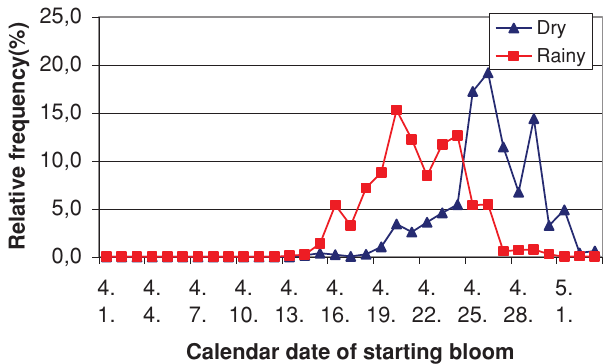
Figure 4. Time series of the beginning of bloom in pear gene bank plantation (Újfehértó, 1984–2001)